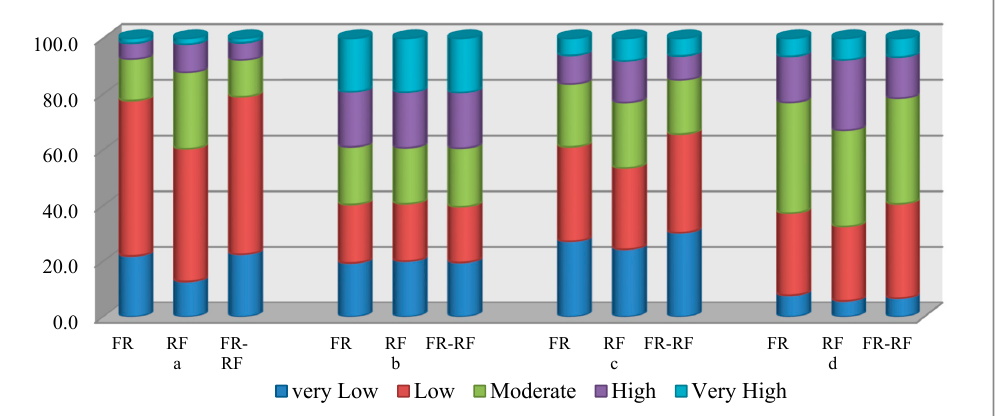
Figure 4. Classification of resulting map using FR, random forest (RF) and ensemble model: ( a ) Equal interval; ( b ) quantile; ( c ) natural break; ( d ) geometrical interval.